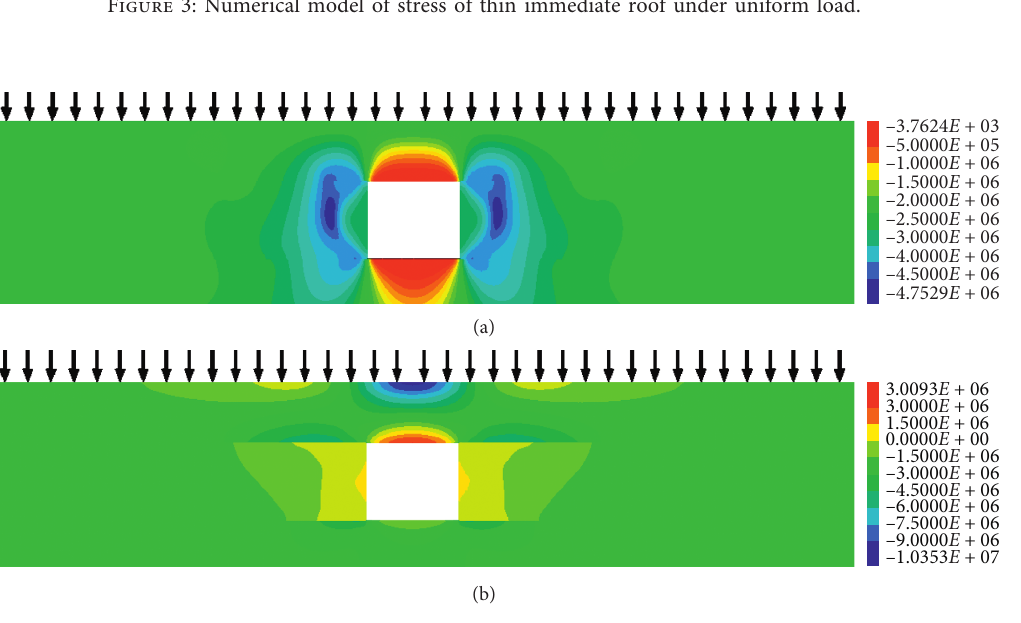
Figure 4: The stress of thin immediate roof under uniform load. (a) The cloud diagram of the vertical stress. (b) The cloud diagram of the horizontal stress.